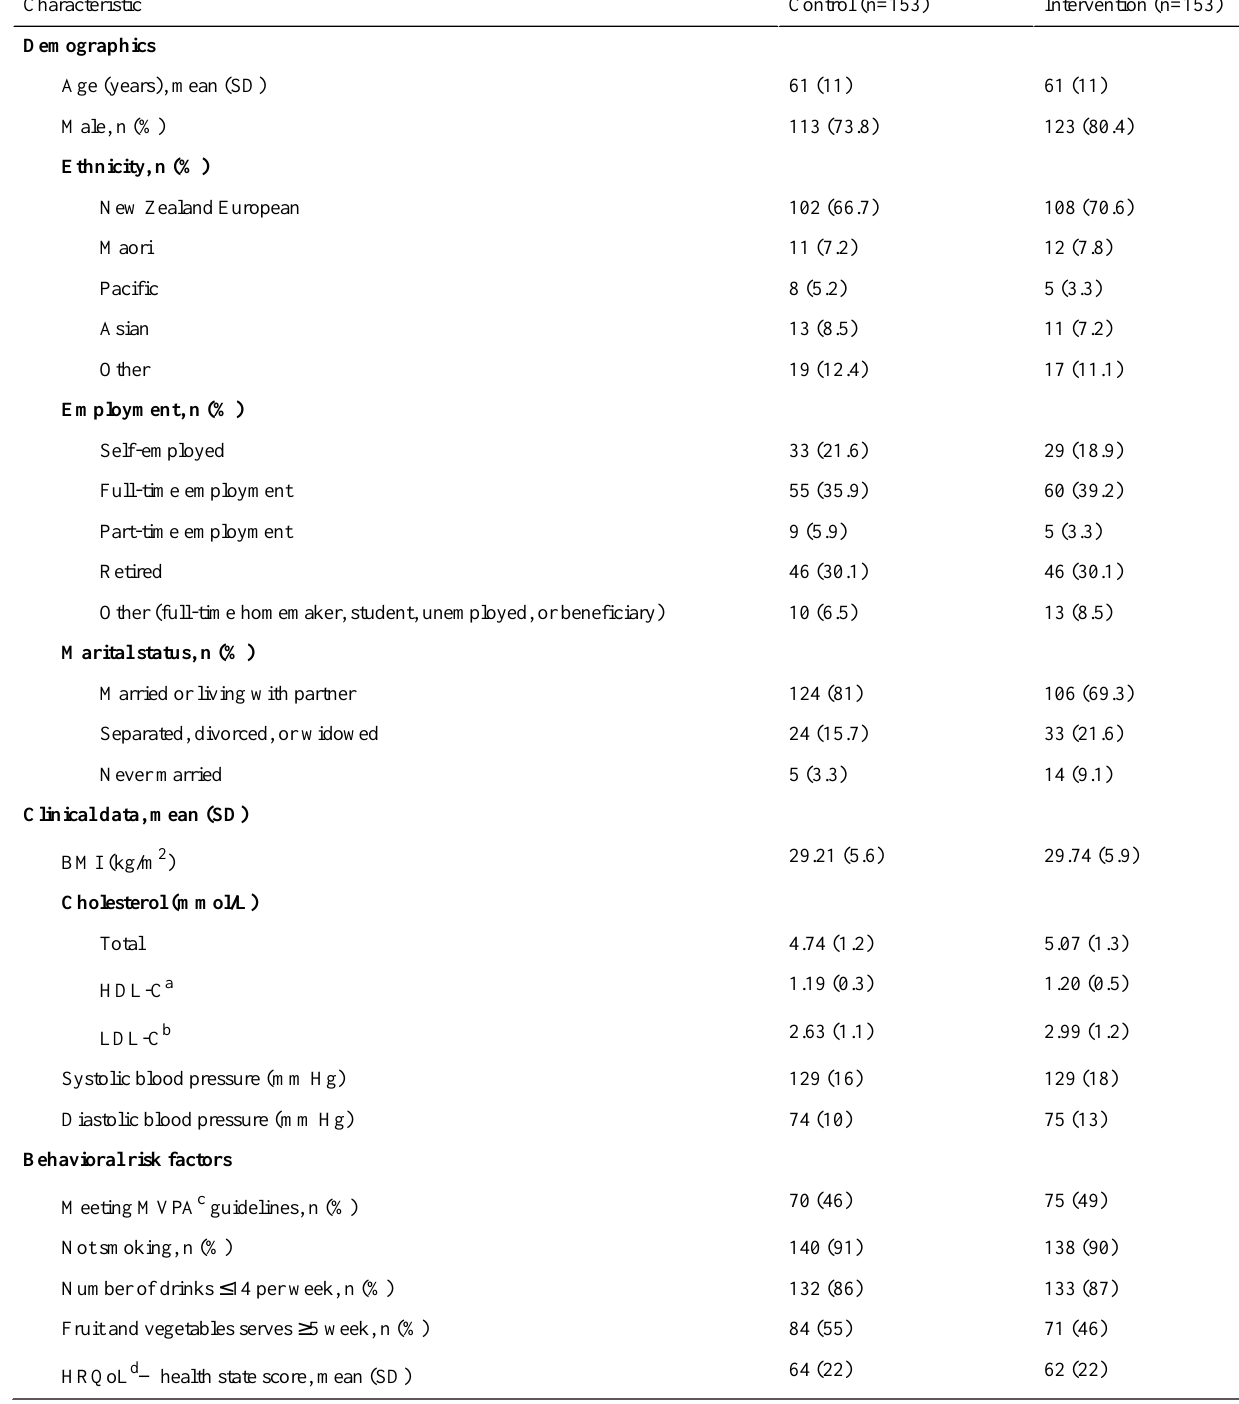
Table 1. Baseline demographic, clinical, and behavioral data of all randomized participants